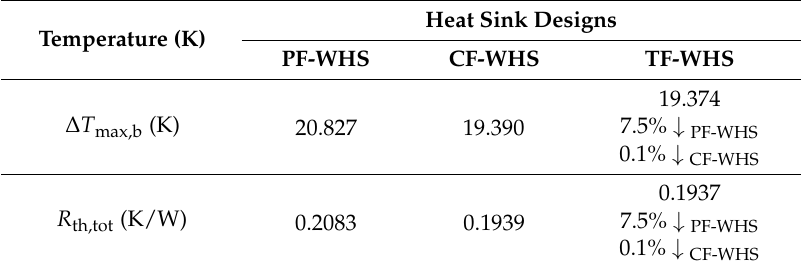
TF heat sinks without hotspot (WHS) at the total flow rate of 0.01